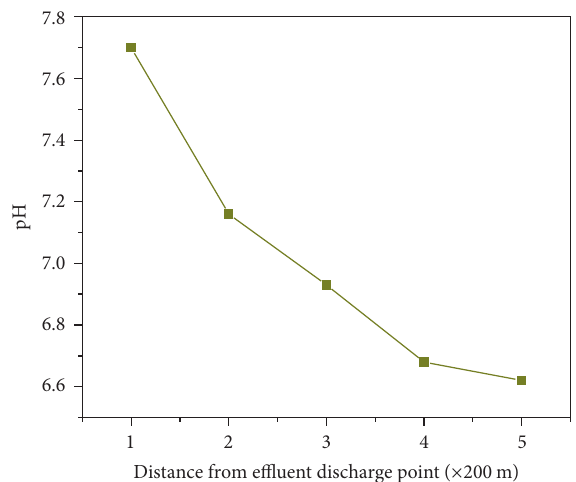
Figure 1: pH of water samples with distance from the source (efflu- ent